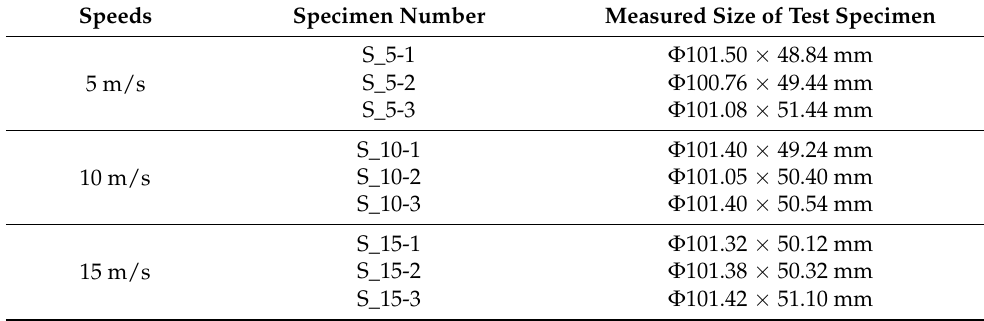
Figure 4. Original stress wave. ( a ) SHPB test collection wave. ( b ) The three waves graph.